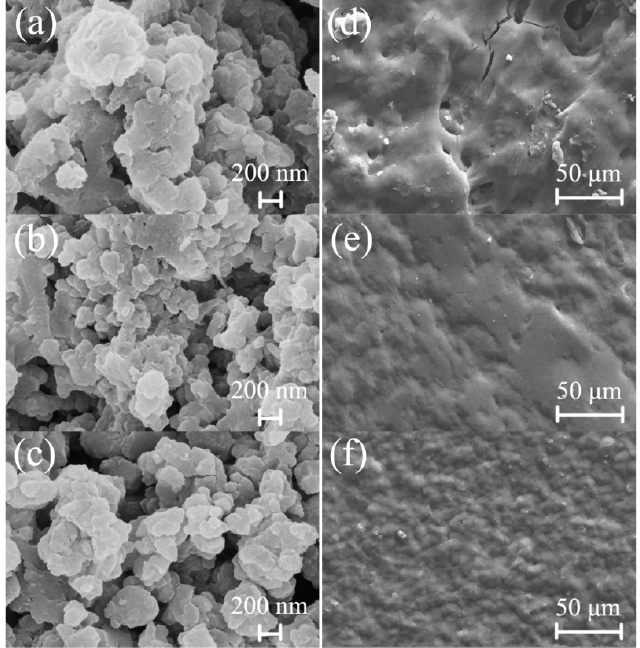
Figure 4. SEM images of CSA@POT ( a ), 3-MG/CSA@POT ( b ), 5-MG/CSA@POT ( c ), CSA@POT coating ( d ), 3-MG/CSA@POT coating ( e ), and 5-MG/CSA@POT coating ( f ).